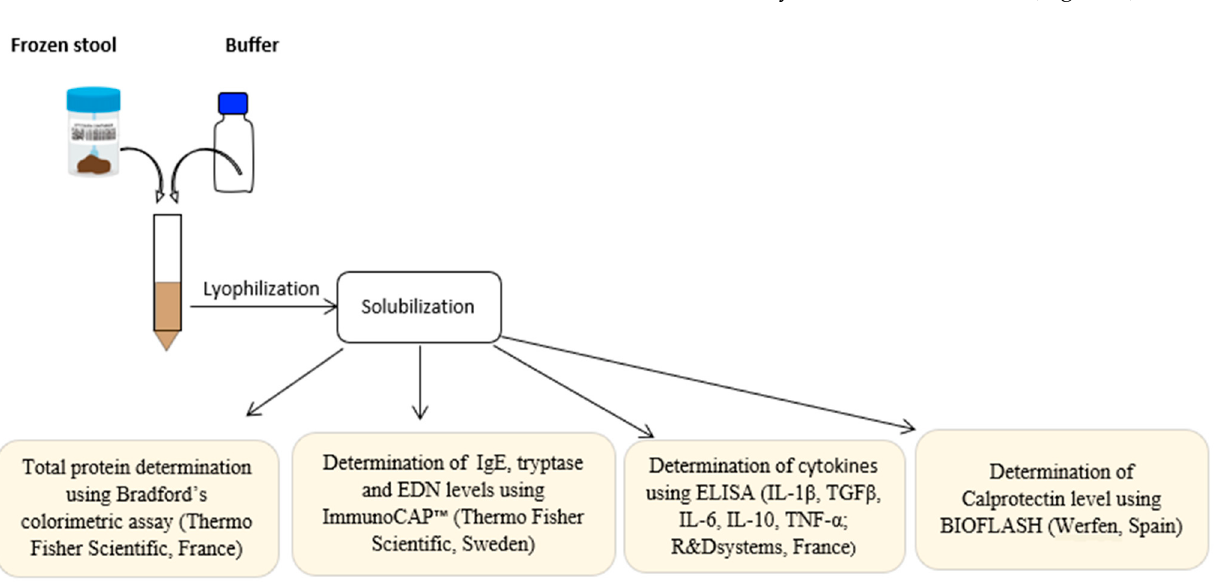
Figure 1. Fecal extraction protocol.